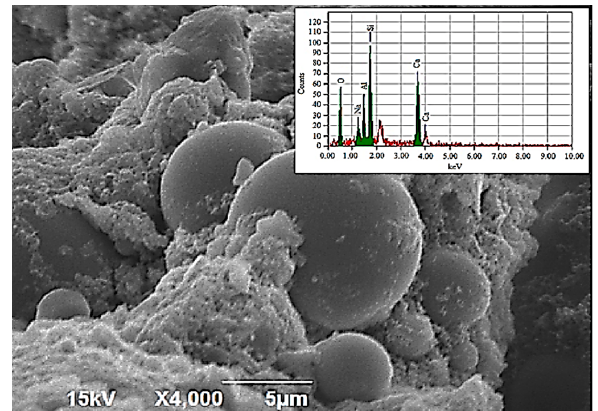
Figure 9. Micrograph and EDX plot for the pulverized geo-polymer paste.